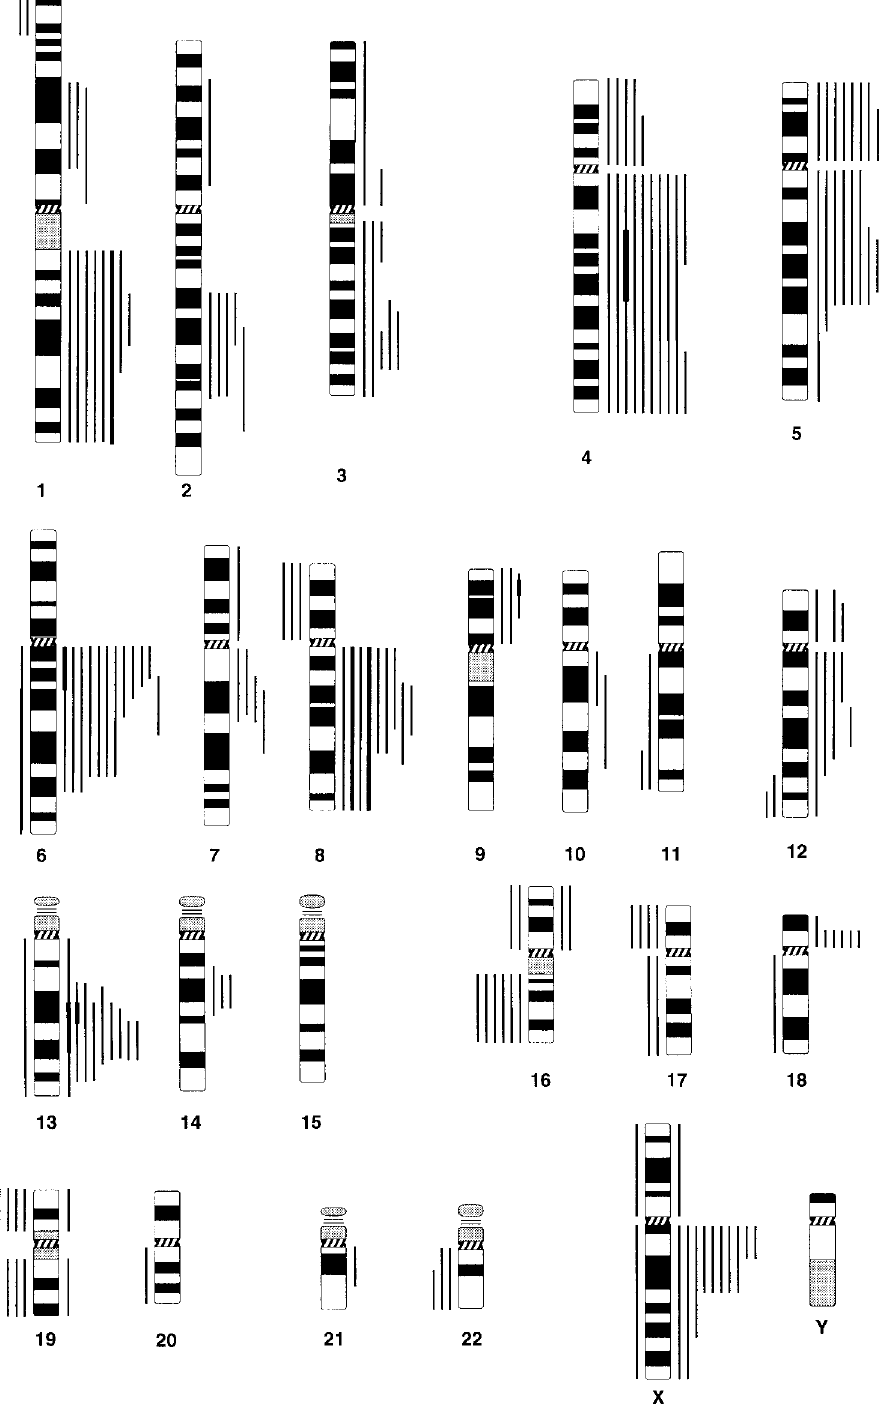
Fig. 1. Karyogram of chromosomal gains and losses in primary breast carcinomas ( n = 17). All tumors were (cid:1) 10 mm in size (T1b) and bars on the right side of the chromosome ideogram indicate gains and bars on the left side indicate loss of genetic material. Solid bars denote high-level copy number increases